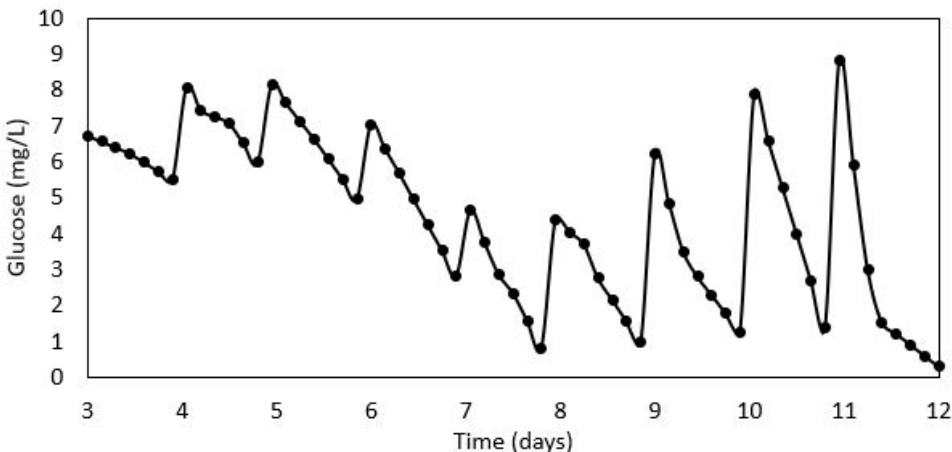
Figure 2. The glucose input profiles for a training batch using the correct approach of updating the glucose concentration instantaneously.